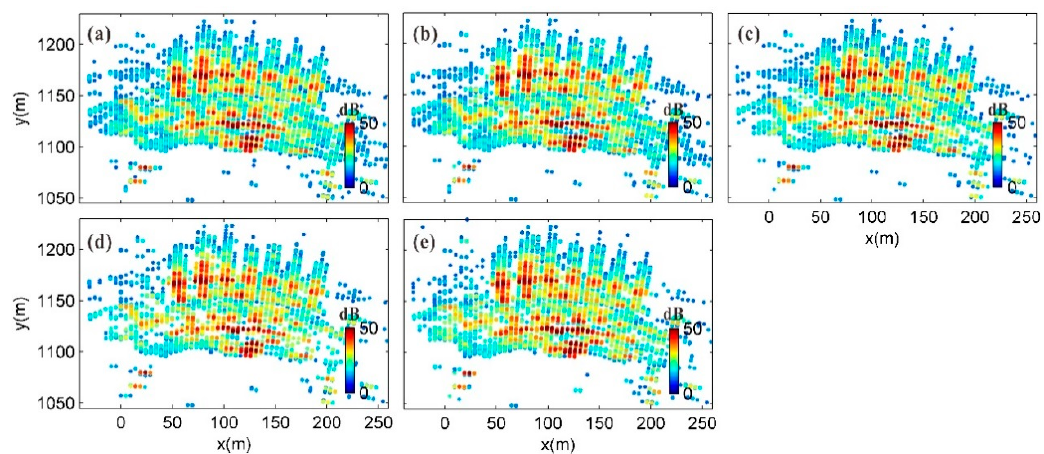
Figure 8. TSNR plots of average images of image subsets: ( a – e ) TSNR plots of average images of image subsets S1 to S5, respectively.